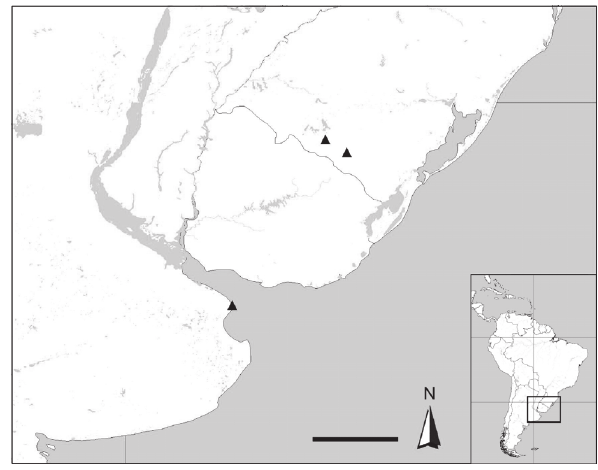
Figure 12. Distribution of Misumenoides athleticus comb. nov. in southern of South America. Scale bar: 250